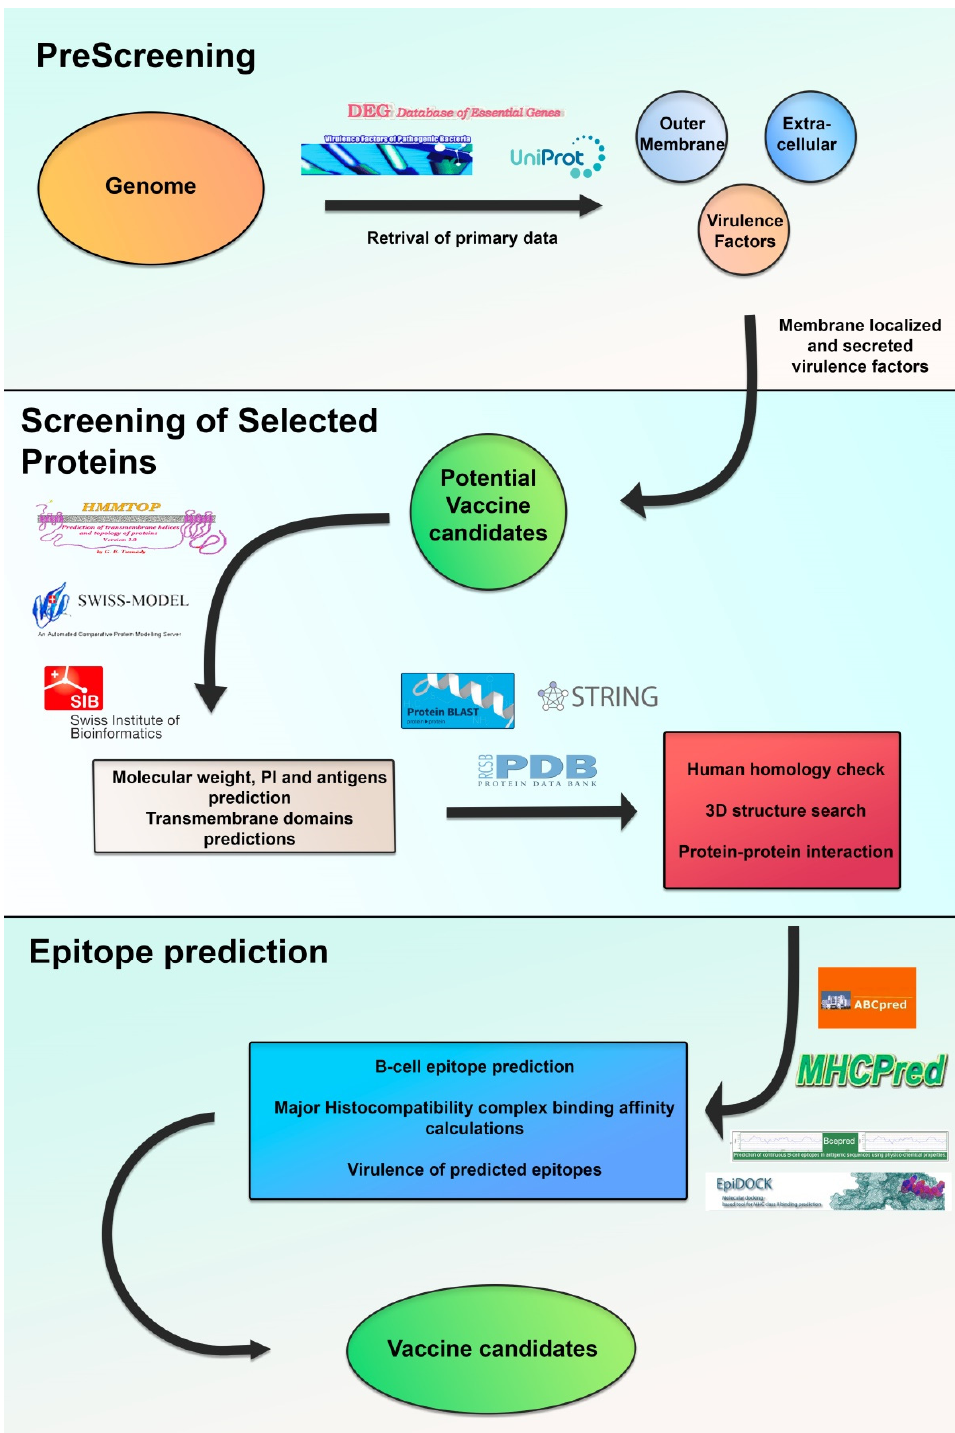
Figure 2. Reverse-vaccinology schematic workflow: Step (1)—Prescreening of primary data (e.g., genome) and prediction of subcellular localization, essentiality and virulence. Step (2)—Screening of the previous selected proteins for their immuno-protective potential, including the criteria mo- lecular weight (MW) prediction, protein structural details and human homologue search. Step (3)— Epitope prediction using specific algorithms in order to obtain broad spectrum immunogenic pep- tides. The predicted epitopes are then screened for epitopes capable of binding higher numbers of MHC alleles in greater efficacy.